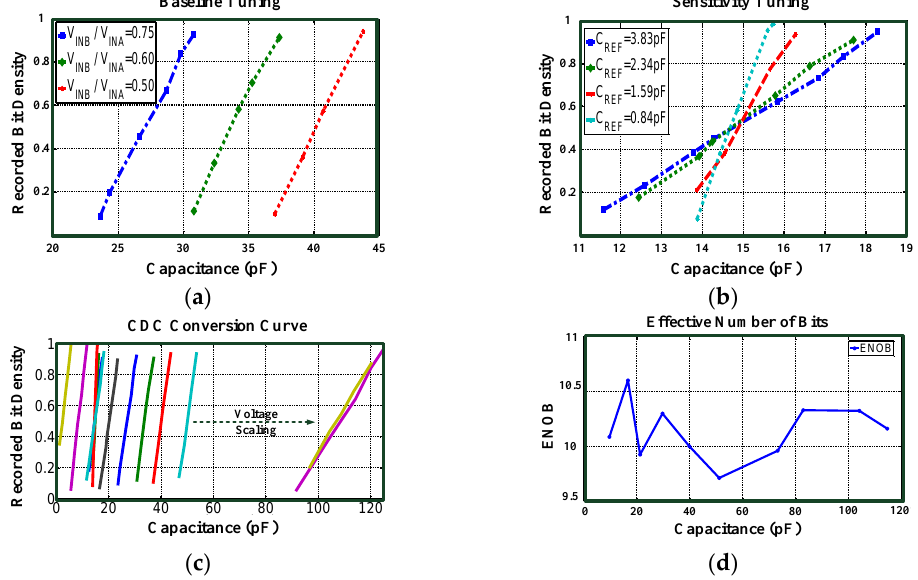
Figure 9. ( a ) Baseline tuning of the CDC; ( b ) Sensitivity tuning of the CDC; ( c ) CDC conversion curves; ( d ) The ENOB of the CDC.